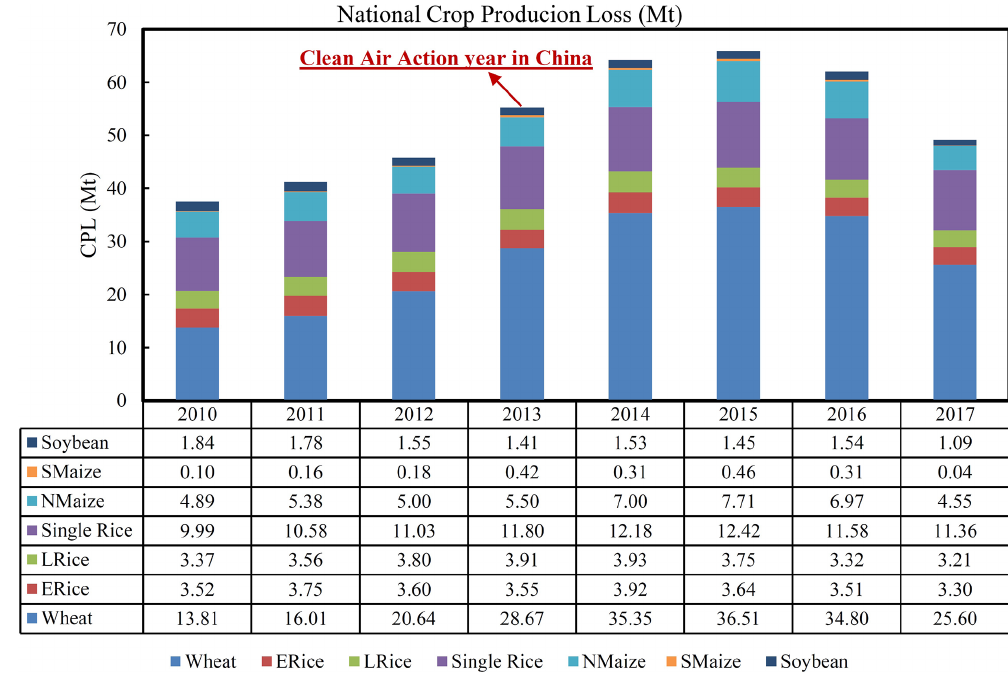
Figure 4. National crop production loss (CPL) for major crops, with SMaize for south maize, NMaize for north maize, LRice for Late Rice, ERice for early rice. Unit is million metric tonnes.